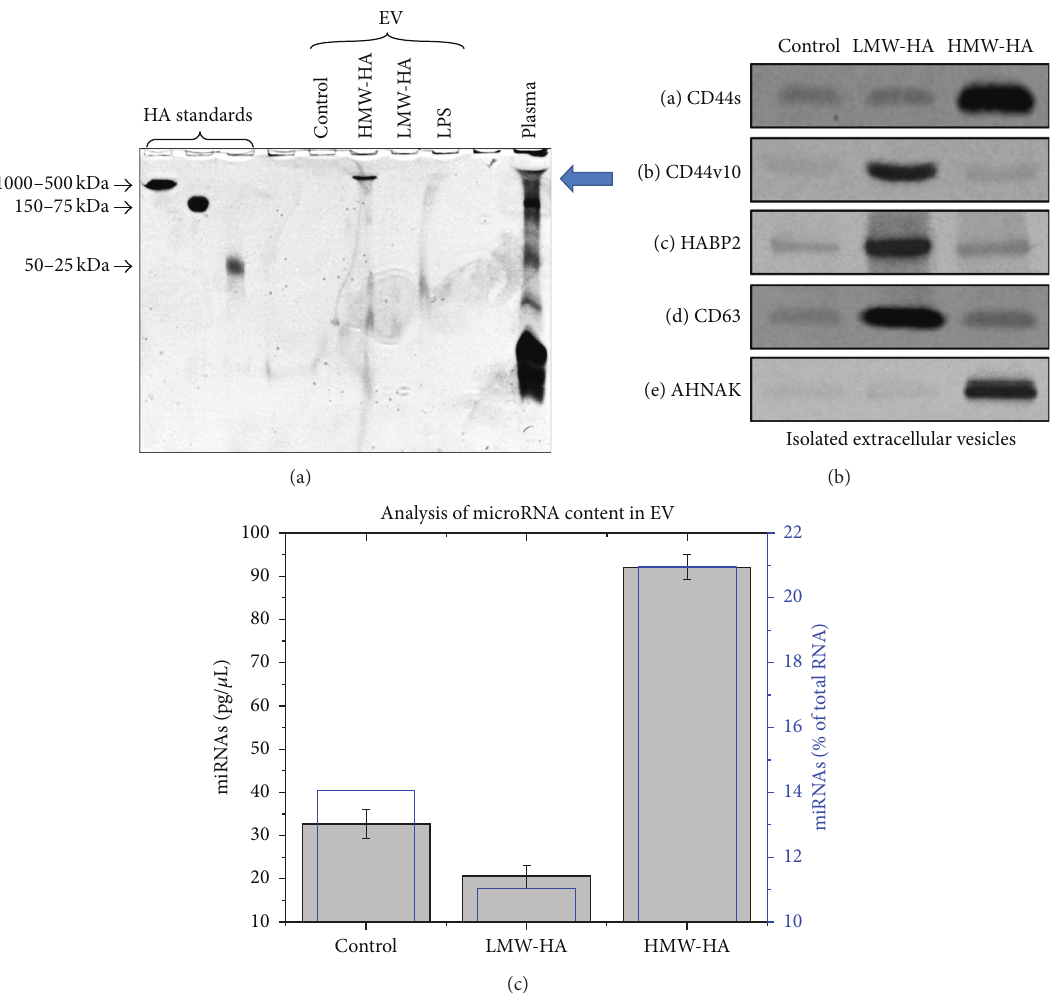
Figure4:CharacterizationofpotentialbioactivecomponentsinHA-inducedEV.Panel(a):HPMVECweregrowntoconfluenceandswitched to serum-free media and either no HA (control), 100nM HMW-HA, 100 nM LMW-HA, or 500 ng/mL LPS for 24 hours. EVs were then isolated, run on 4–20% TBE gels, and stained with Alcian blue. Purified enlargeosomes contained HA of ∼ 1 million Da (see arrow) consistent with HMW-HA which we have previously demonstrated to be barrier enhancing [4, 5, 7, 8]. In contrast, control, LMW-HA, or LPS-induced EV contained negligible HA. Human plasma was used as a control. Panel (b): HPMVEC were grown to confluence and switched to serum-free media and either no HA (control), 100nM HMW-HA, or 100nM LMW-HA for 24 hours. EVs were then isolated, run on SDS-PAGE, and immunoblotted with anti-CD44 (IM-7) (a), anti-CD44v10 (b), anti-HABP2 (c), anti-CD63 (d), or anti-AHNAK (e) antibodies. HMW-HA- induced enlargeosomes expressed the EC barrier enhancing CD44 isoform, CD44s (standard form) [4, 7]. In contrast, LMW-HA-induced exosomes expressed the EC barrier disrupting HA binding proteins, CD44 isoform CD44v10, and the extracellular serine protease, HABP2 [7, 25]. Basally secreted EV (control) had low expression of these molecules. Panel (c): isolated EVs as described in Panel (b) were subjected to RNA isolation and analysis (see Section 2). Compared to control EV, LMW-HA-induced EV had less total RNA and microRNA while HMW-HA-induced enlargeosomes had ∼ 2-fold higher levels of total RNA and